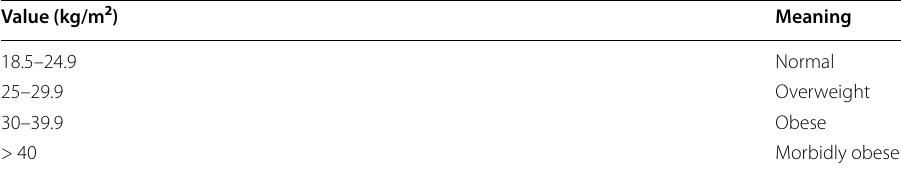
Table 4 Description of BMI’s